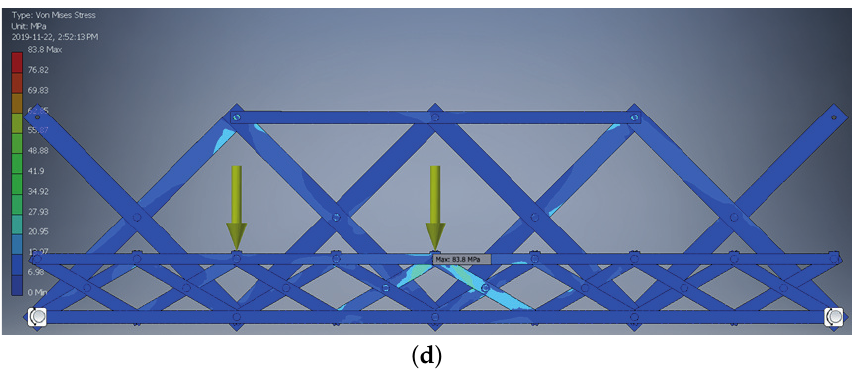
Figure 15. The simulation results of CSCI models. ( a ) CSCI model-A. ( b ) CSCI model-B. ( c ) CSCI model-C. ( d ) CSCI model-D. Table 1. The simulation results of DWT & CSCI models A, B, C, D by Autodesk Inventor 2018.